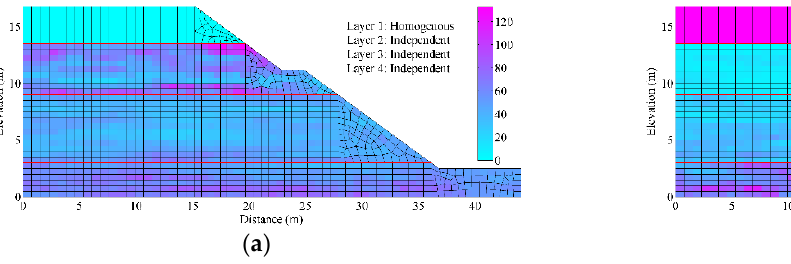
Figure 20. A typical realization of transversely anisotropic CCRF yielded by strategy 4. ( a ) Random field of c. ( b ) Random field of ϕ.